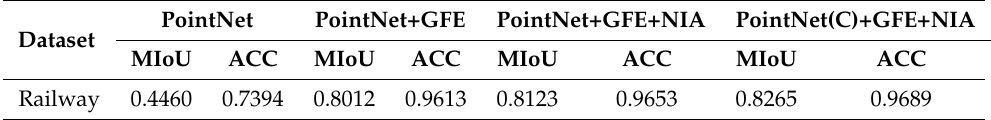
Table 7. The performance of different modules proposed in this work in aspects of MIoU and ACC.